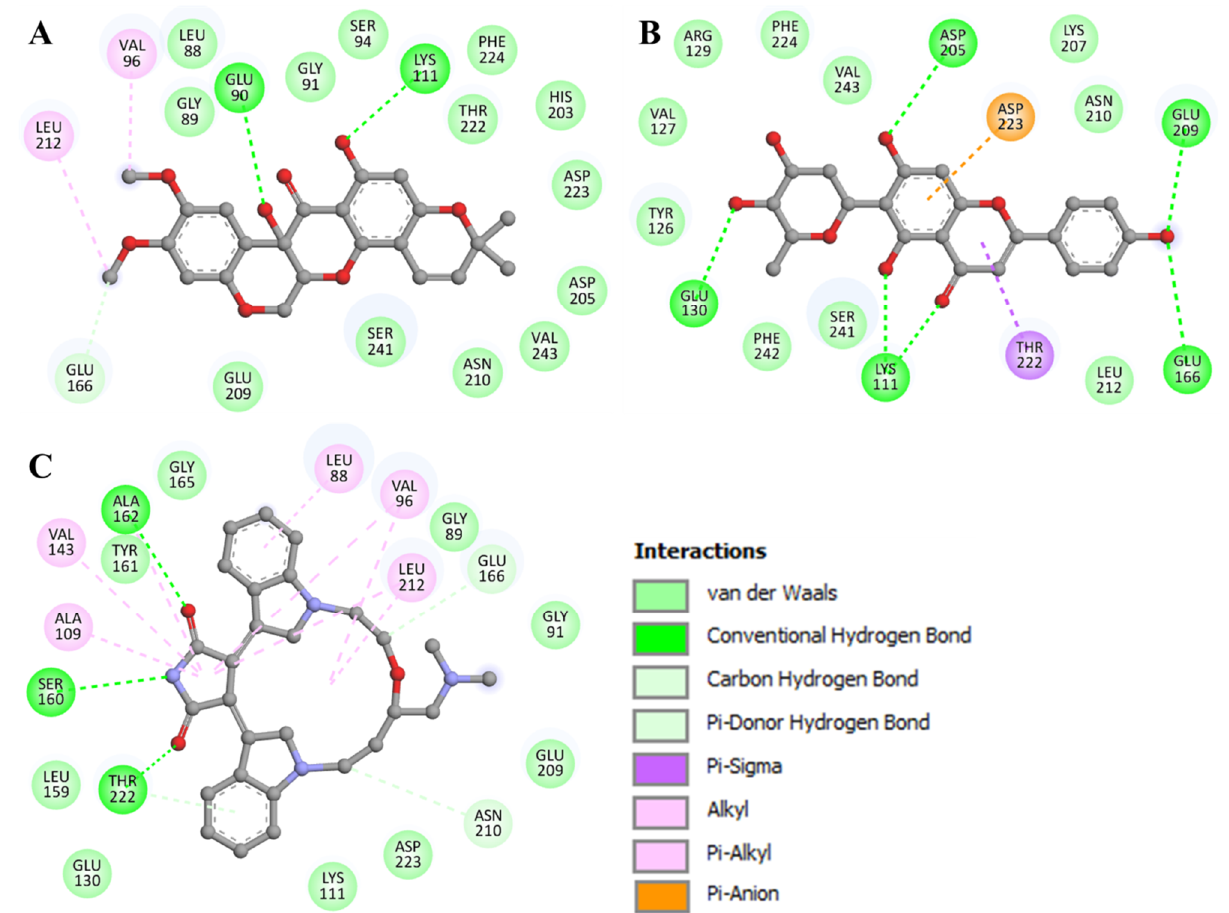
Figure 2. A 2D presentation of PDPK1 residues interacting with ( A ) 11-Hydroxytephrosin, ( B ) To- rosaflavone A, and ( C )